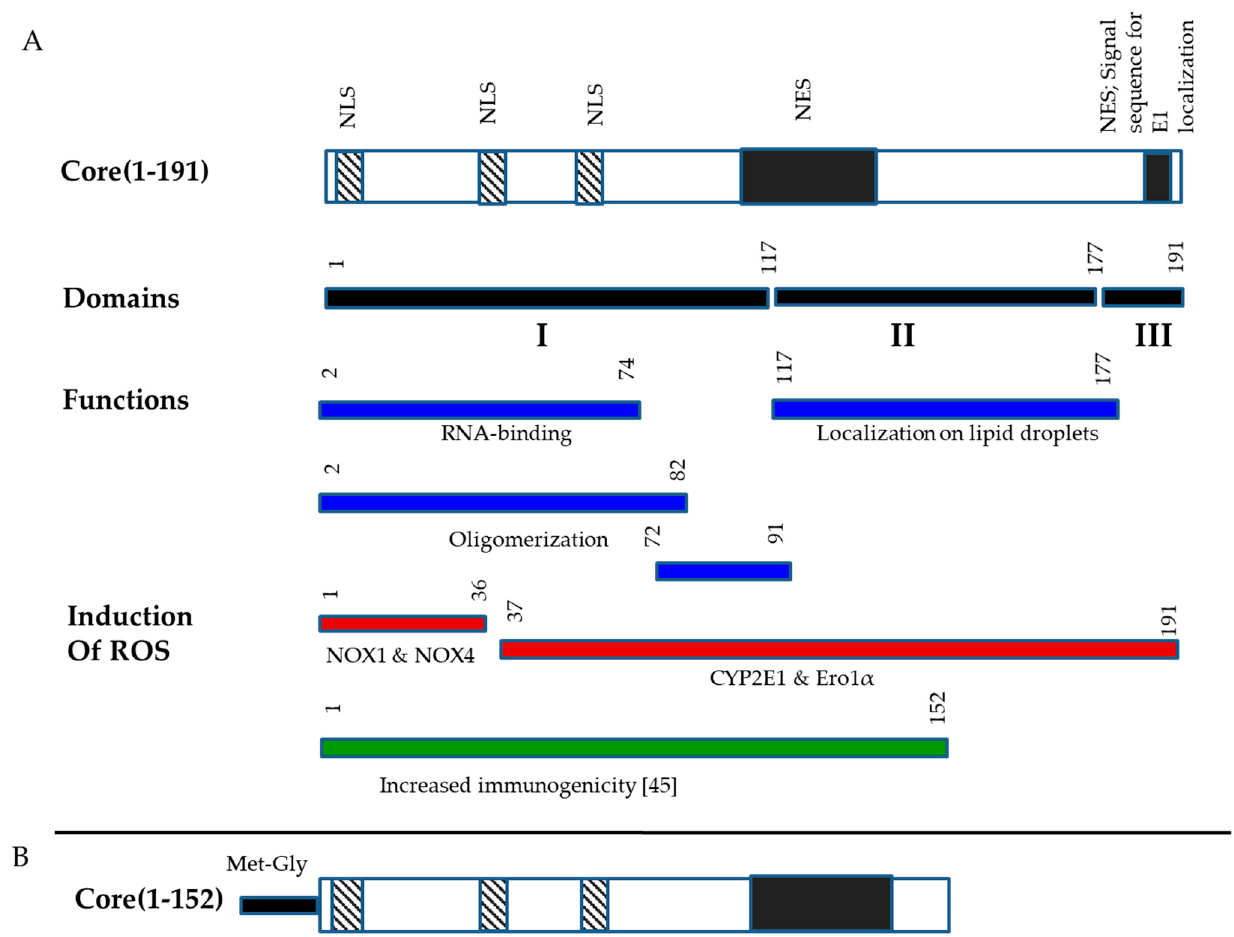
Figure 1. Structure of HCV core and its variant used for DNA immunization. Structural and structural domains of HCV core, domains responsible for RNA-binding, oligomerization, localization to lipid droplets, nuclear localization (NLS), nuclear export signals (NES), signal sequence for localization of E1 protein, induction of oxidative stress [13] and release of immunosuppression in in vivo tests [36] ( A ); Structure of HCV core aa 1-152 (Core152) encoded by expression optimized gene for the purpose of DNA immunization ( B ).